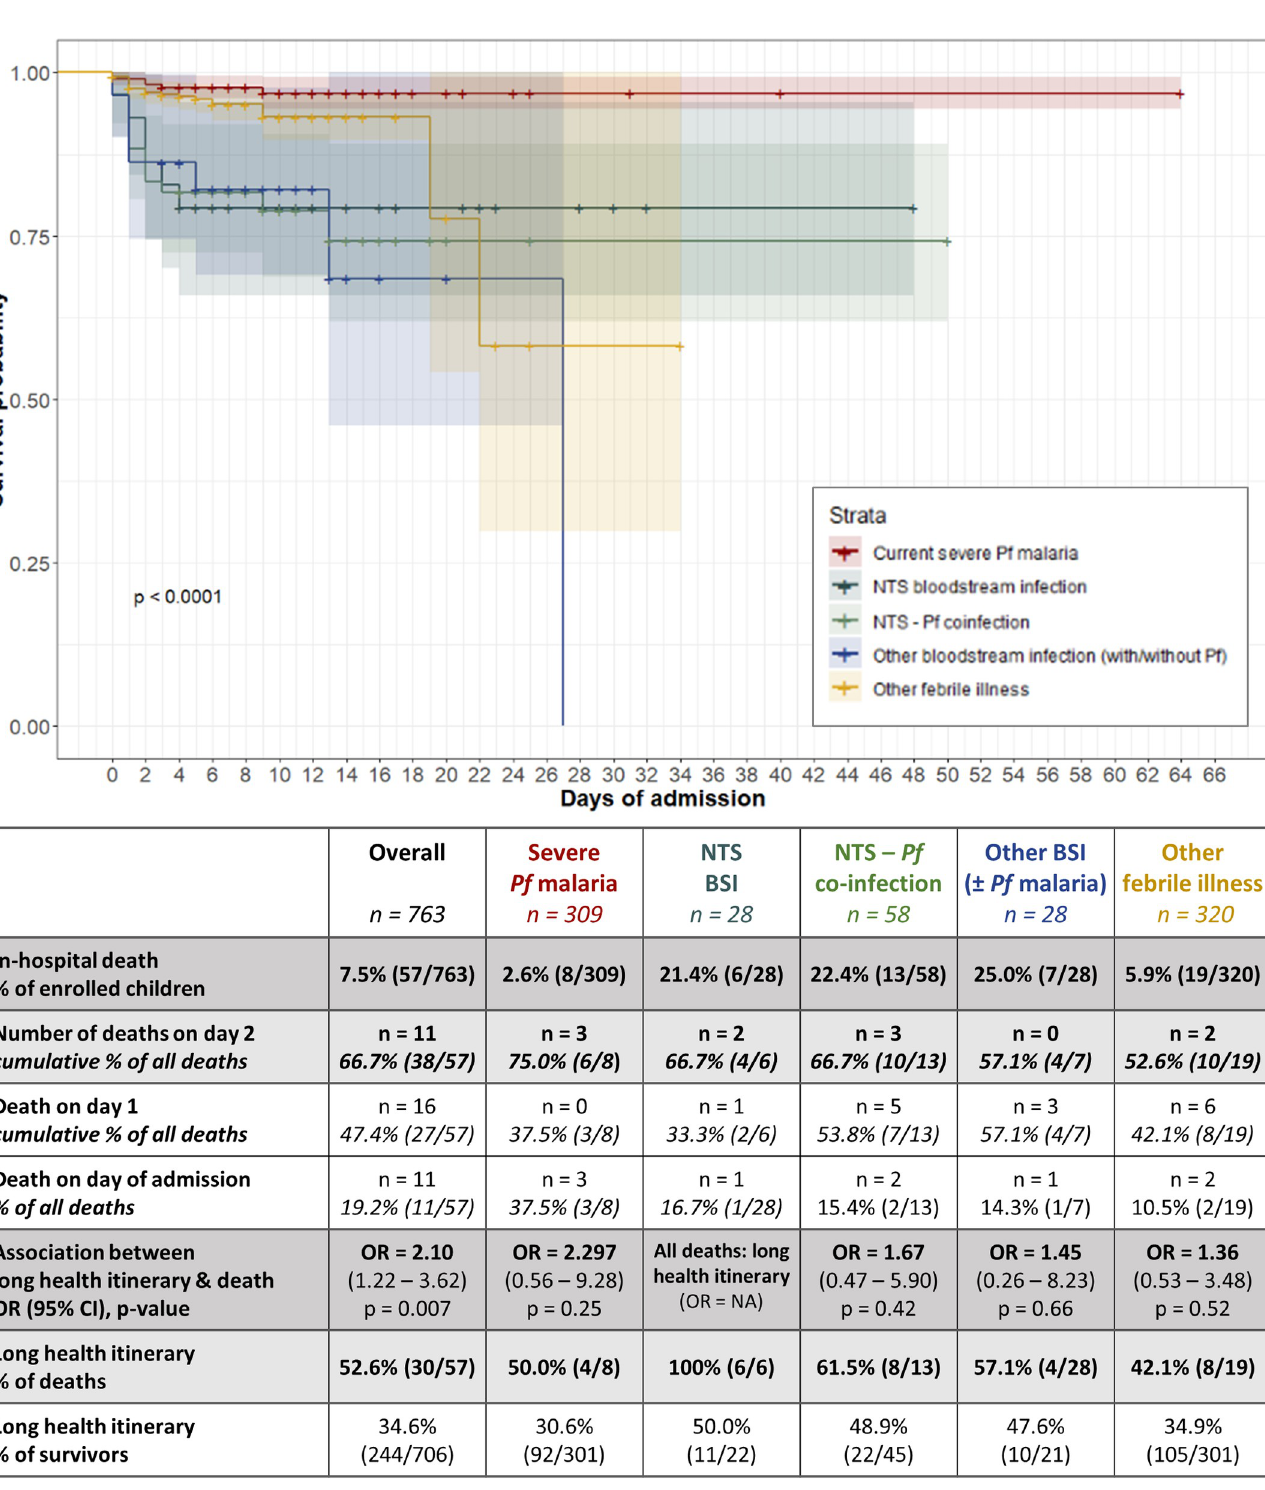
PLOS NeglectedTropical Diseases | https://doi.org/10.1371/journal.pntd.0011156 March 6, 2023 14 /